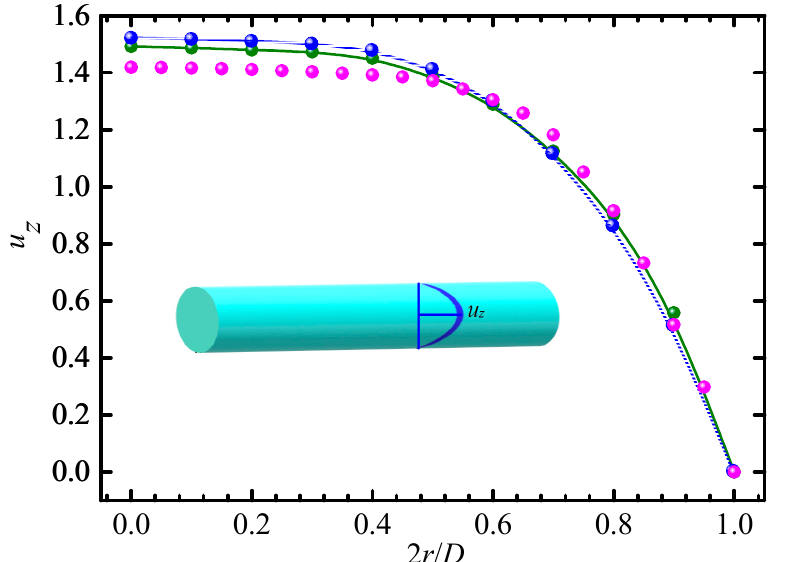
Figure 2. Axial velocity profile along the radial direction. ⸺ ● ⸺ : present numerical result; ⸺ ● ⸺ : analytical result [25]; ● : experimental result [25].